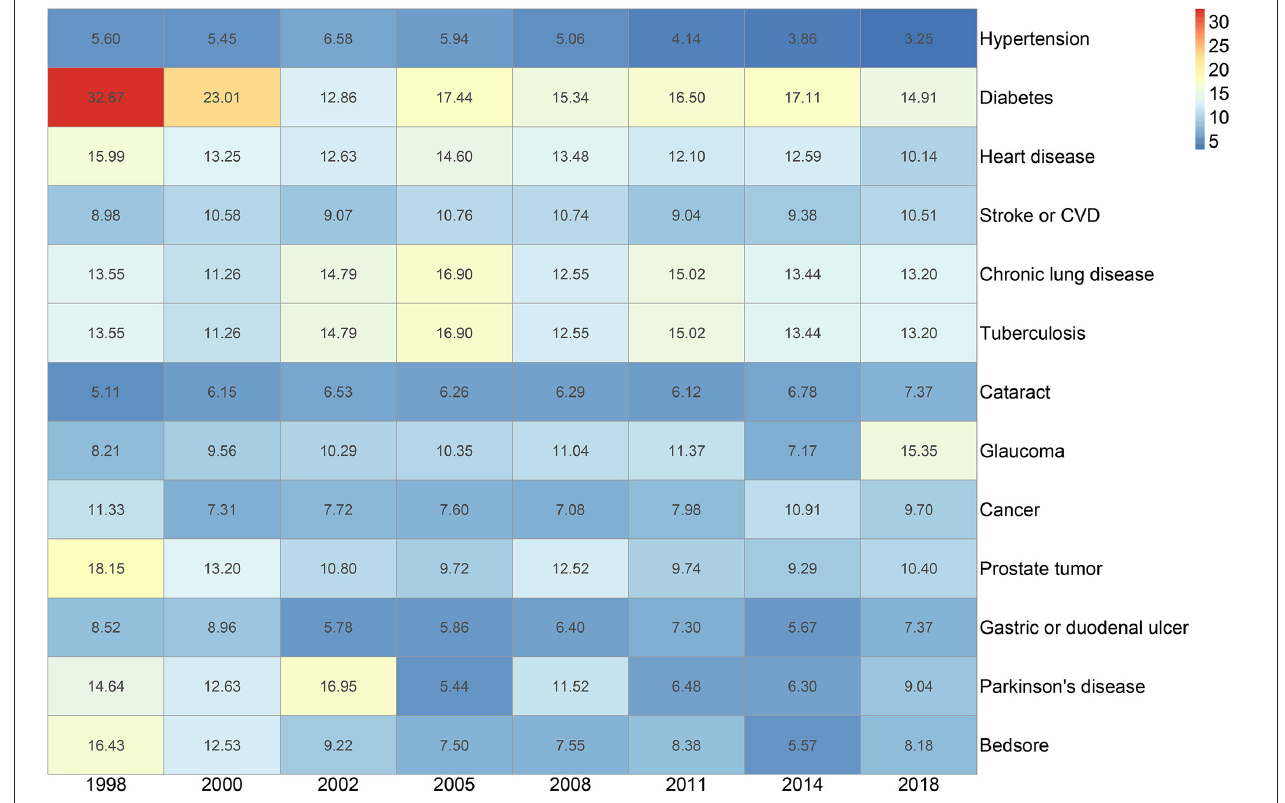
region (15, 25), and hospital admission (26, 27)], or referred to a cross-sectional study